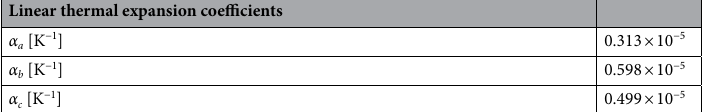
Table 3. Linear thermal expansion coefficients of olivine Mg 1.84 Fe 0.16 SiO 4 . Linear thermal expansion coefficients